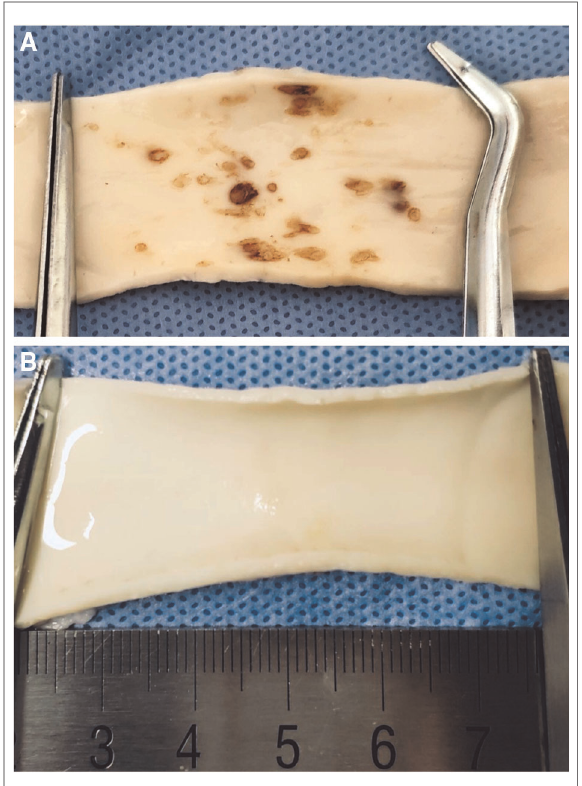
FIGURE 6 ( A ) Many thermal injury spots were found in the inner wall of the “ carotid artery ” after the ablating of the plaque without protection. ( B ) No thermal injury spots were found in the inner wall of the “ carotid artery ” after the ablating of the plaque with spade-protection. fi fth must have lower rate of embolic and restenosis. As a matter of fact, both CEA and CAS still have the limitations of their own, such as extensive invasiveness and in-stent restenosis.